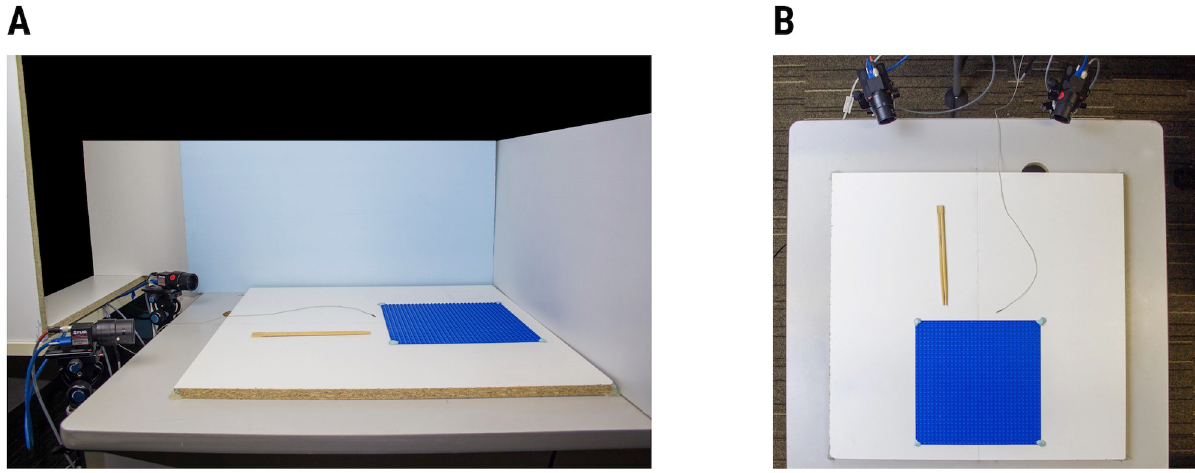
Fig 1. DLC setup as seen from (a) side and (b) overhead views. The Lego plate marks the boundaries of the testing area. Wooden dowels and the Fastrak microsensor are shown separately for easier